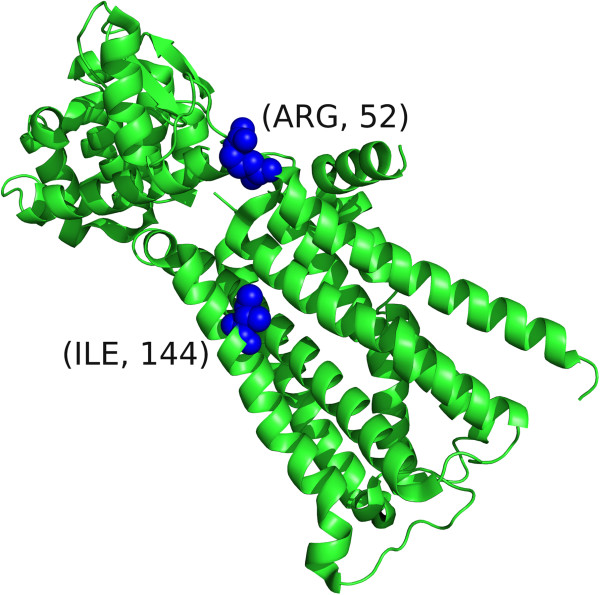
CHRM 2 clustering. The CHRM2 structure (PDB ID: 3UON) where residues 52 and 144 are highlighted.